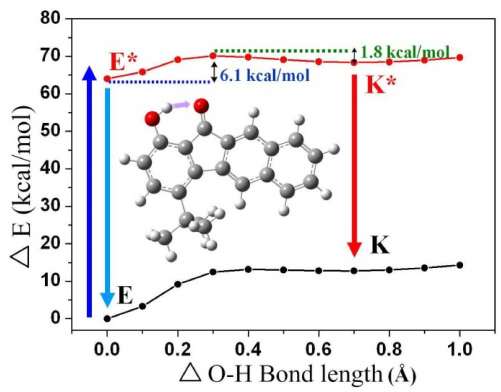
Figure 9. Potential energy curves (PECs) from enol form (E) to keto form (K) of 1 at the ground state and excited state. The calculations are based on the optimized ground state geometry (S 0 state) at the B3LYP/6-31G**/ level using Gaussian 03W.